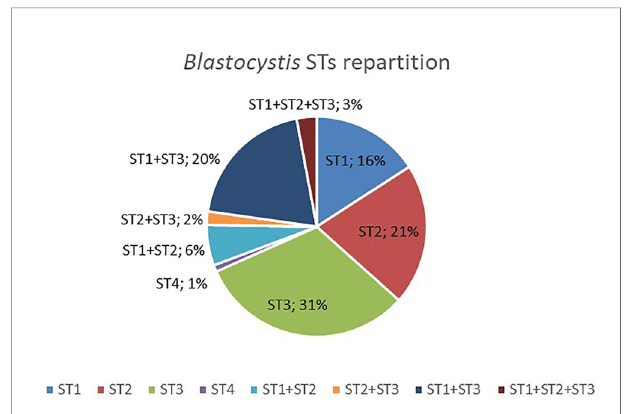
FIGURE 1 | Distribution of Blastocystis STs detected in colonized Cameroonian